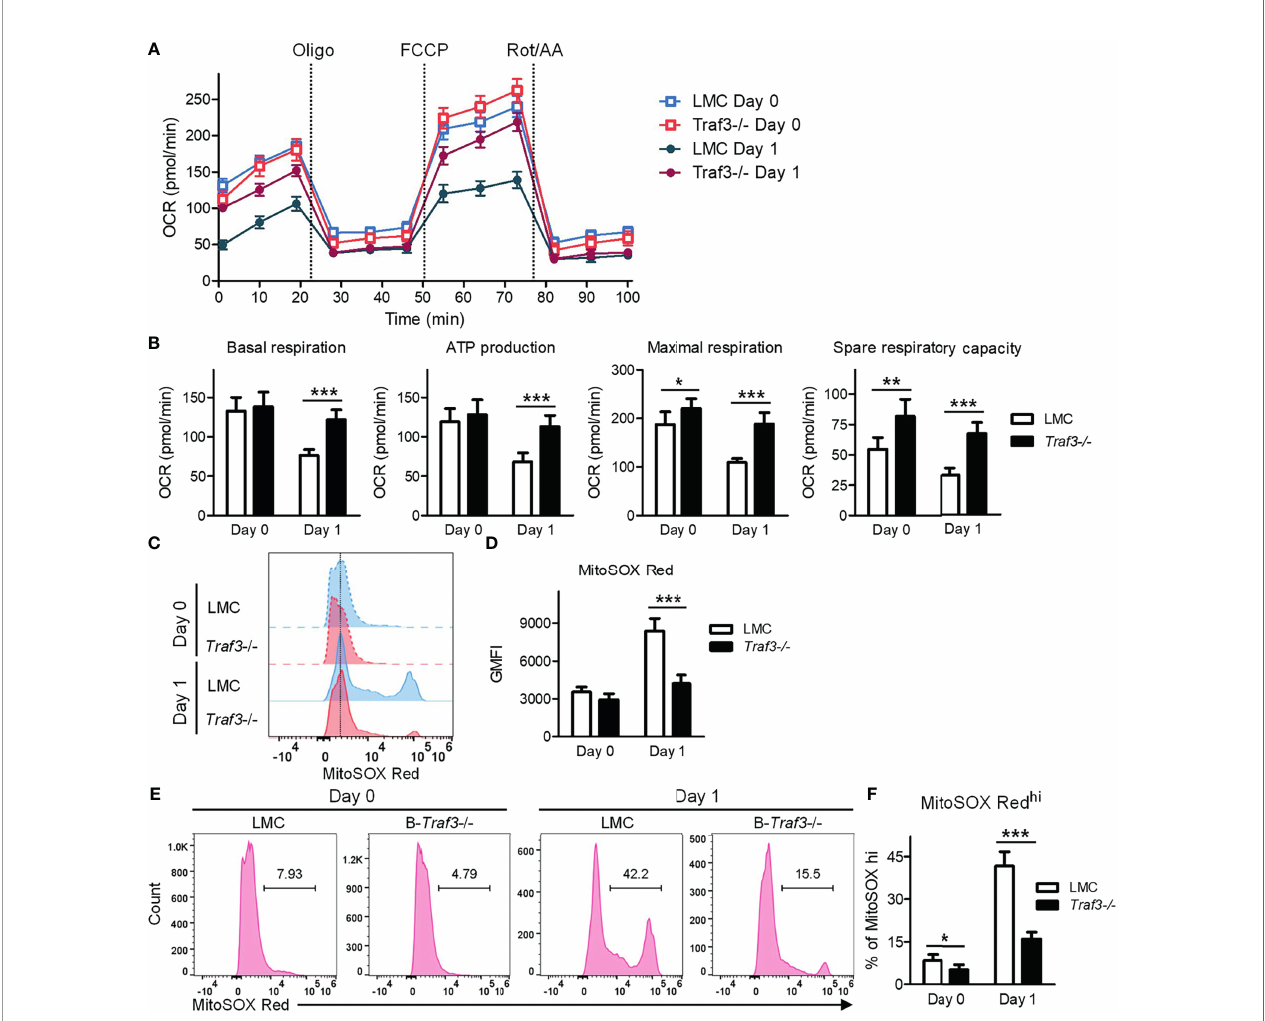
FIGURE 5 | Regulation of mitochondrial function by TRAF3 in resting B cells. Splenic B cells were puri fi ed from gender-matched, young adult (8-12-week-old) naïve LMC or B- Traf3 -/- mice. Puri fi ed cells were analyzed directly (Day 0) or at day 1 after ex vivo culture. (A, B) Mitochondrial respiration and energy production determined by the Seahorse Cell Mito Stress Test. (A) Kinetic changes of the oxygen consumption rate (OCR). Injection time points of oligomycin (Oligo), FCCP and rotenone/antimycin A (Rot/AA) are indicated in the fi gure. (B) Graphical results of the OCRs for basal respiration, ATP production, maximal respiration and spare respiratory capacity. (C – F) Mitochondrial superoxide levels analyzed MitoSOX Red staining and fl ow cytometry. (C) Representative FACS histogram overlay comparing the levels of MitoSOX Red staining intensity. (D) Graphical results of the geometric mean (GM) of MitoSOX Red fl uorescence intensity (FI). (E) Representative FACS pro fi les showing the gated MitoSOX Red hi populations. (F) Graphical results of the percentage of MitoSOX Red hi subsets. (B, D, F) Graphs shown are the mean ± SD (n = 6/group; * p < 0.05; ** p < 0.01; *** p < 0.001 by t